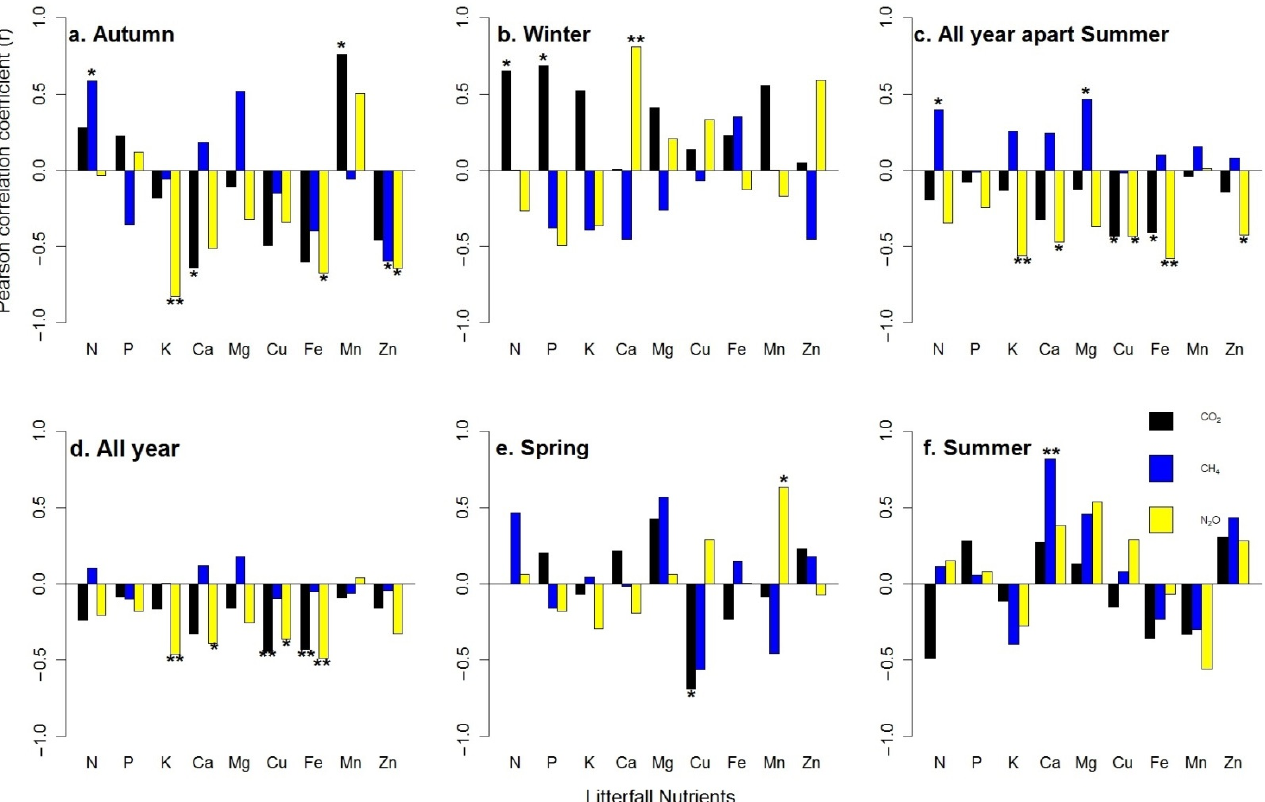
Figure 5. Seasonal pattern (( a ) autumn, ( b ) winter, ( c ) all year apart summer, ( d ) all year, ( e ) spring, ( f ) summer) of correlation of litterfall fractions with GHG fluxes over the study period (16 October until 17 September). Asterisks represent significance levels, accordingly: * = 0.05, ** = 0.01. Each bar represents the mean of the three replicates for each treatment (Control, Traditional and Selective). In the biplot of PCA analysis (Figure 6), the weights of the different variables (nutri- Table 7. Pearson correlation analysis among GHG fluxes and litterfall nutrients, one year after ents, soil GHG fluxes) are presented as arrows and vary by distance from the origin. The thinning, where r: correlation coefficient, p value: significance level. biplot enabled the evaluation of the correlation level among the above-mentioned quanti- fied variables, with lines pointing in the same direction being more closely correlated.